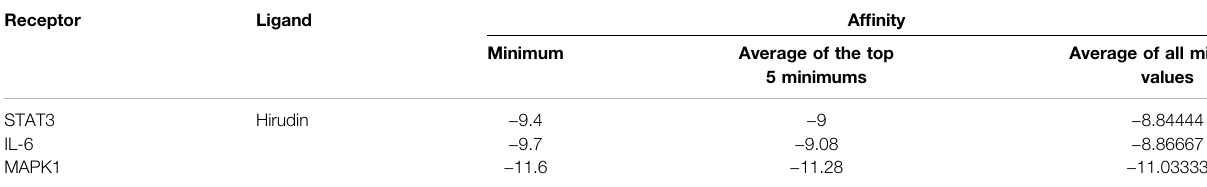
TABLE 2 | Molecular docking af fi nity analyzed by vina.